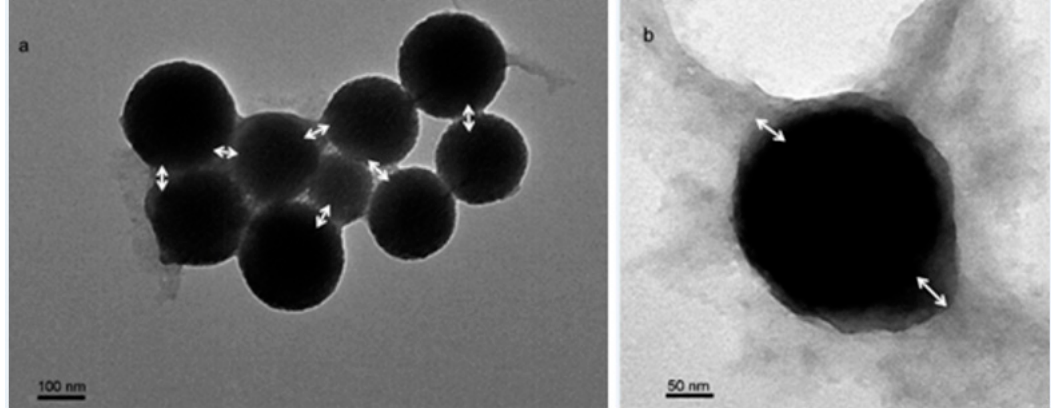
Figure 4. Morphological characterization of FCSNP by transmission electron microscopy. Particles are spherical, with a diameter of ~250 nm, and a polymeric shell is formed at the surface (white arrows). ( a ) and ( b ) were obtained at 3 K and 30 K magnifications, respectively.